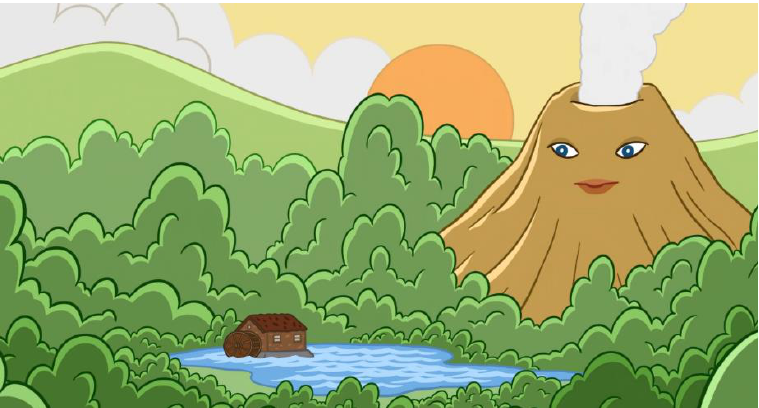
Figure 6. Kerry Tribe, still from The Aphasia Poetry Club (2015), three-channel video with sound, 28:27 min.